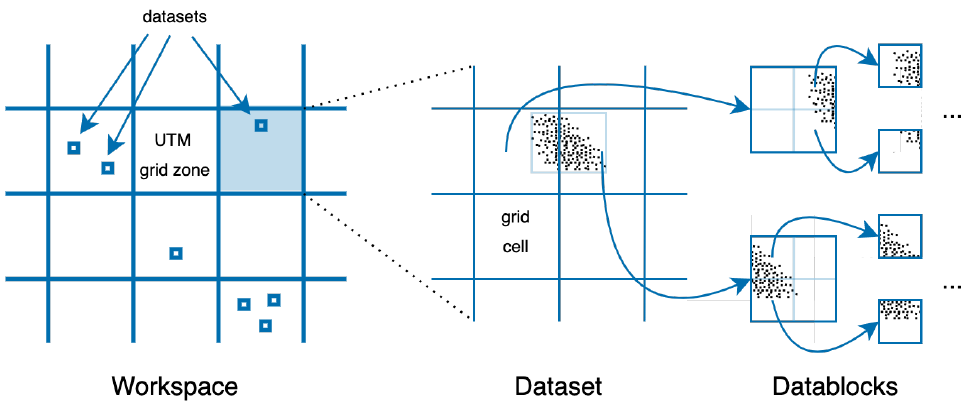
Figure 2. Spatial data structures at the workspace and dataset levels. For the sake of clarity, octrees are depicted as quadtrees at the dataset